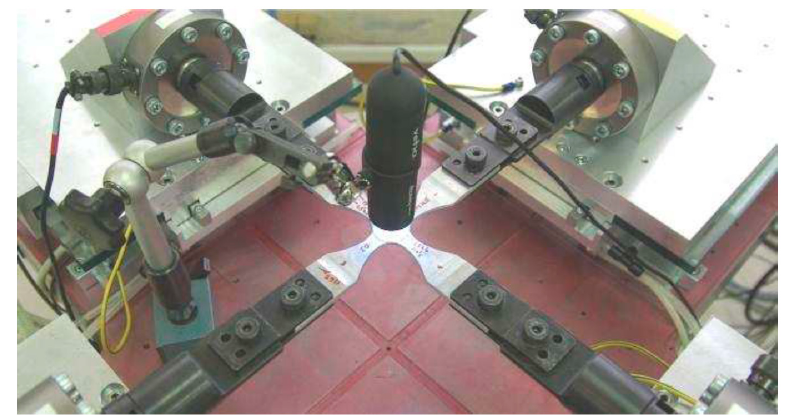
Figure 9. In-plane biaxial fatigue testing machine powered by linear iron core motors [79].